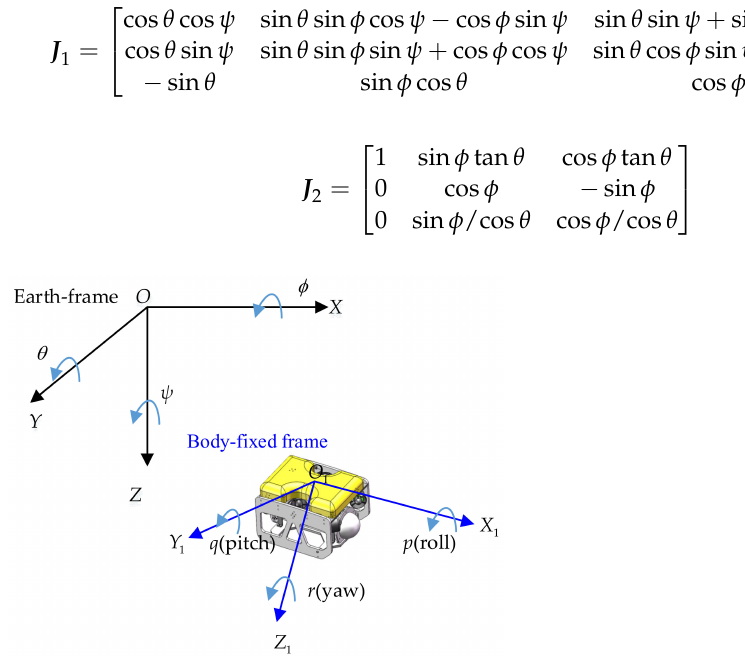
Figure 2. Coordinate systems for